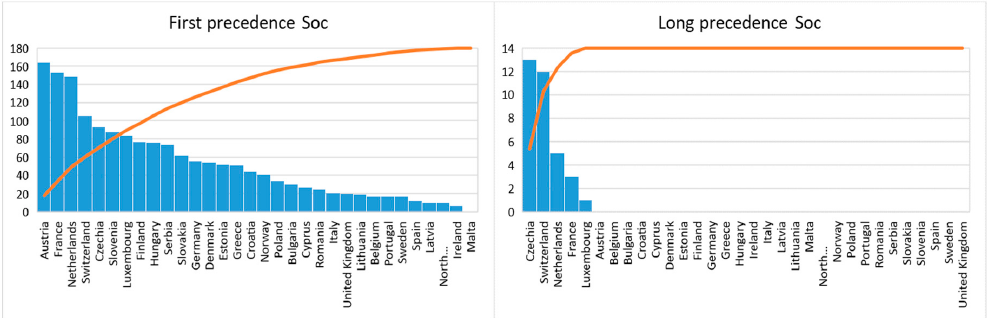
Figure 22. Number of precedence by country, first and long precedence group Soc.